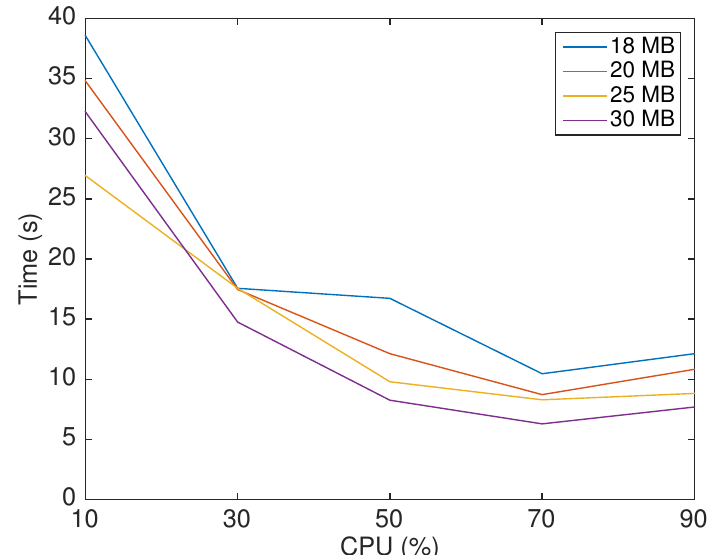
Figure 8. Time performance of the blockchain client for different hardware